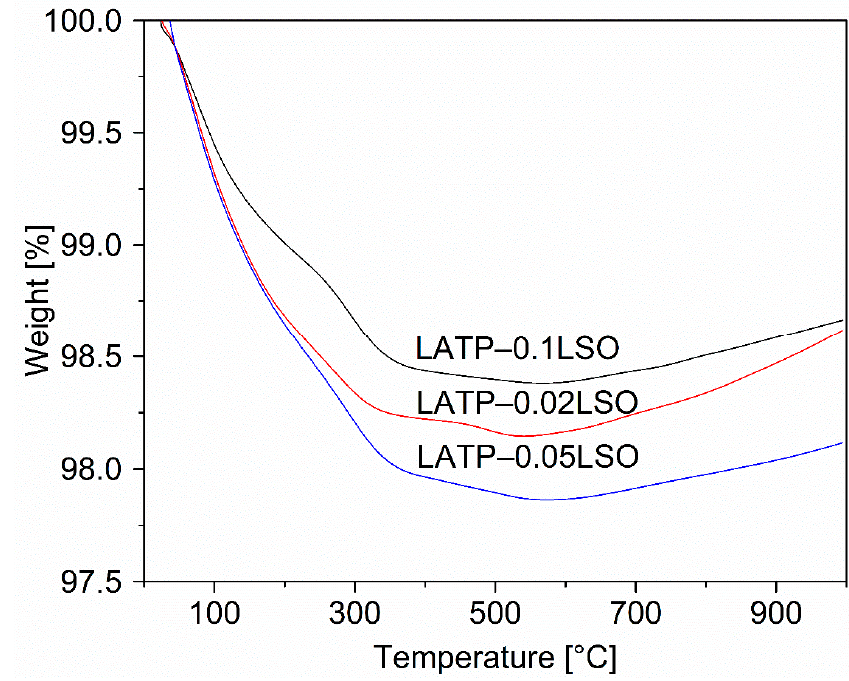
Figure 2. TG plots recorded on LATP–LSO